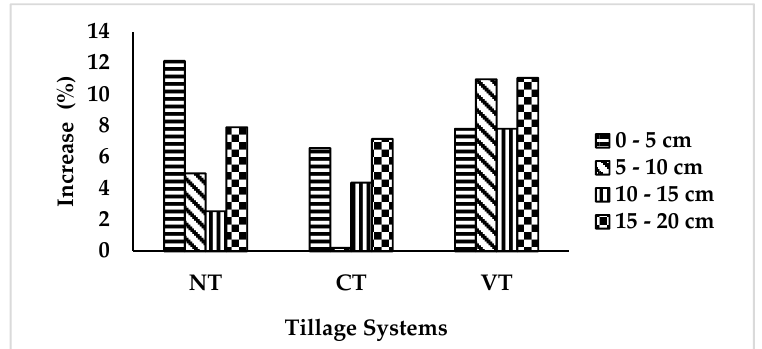
Figure 2. Change of bulk density in 2014 compared to 2013.